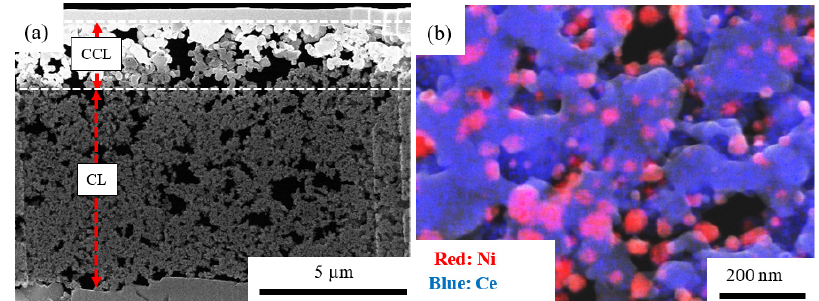
Figure 3. ( a ) Typical secondary electron microscopy (SEM) image of Ni/BCZYN (x = 0) hydrogen electrode. The Ni/BCZYN (x = 0, Ni 10 vol %) CLs was on the electrolyte of BCZY(EL) and was covered on top by the current collecting layer of Ni ‐ BCZY composite CCLs. ( b ) Typical scanning transmission electron microscopy equipped with an energy dispersive X ‐ ray analyzer (STEM ‐ EDX) image of Ni/BCZYN (x = 0, Ni 10 vol %) electrode. The blue images denote the Ce element in BCZYN (x = 0) scaffold. The red images indicate the Ni element in the Ni nanoparticle catalysts. Table 1. Ni particle size and circumference length of triple phase boundary (TPB) of Ni/BCZYN (x = 0 and 0.03).